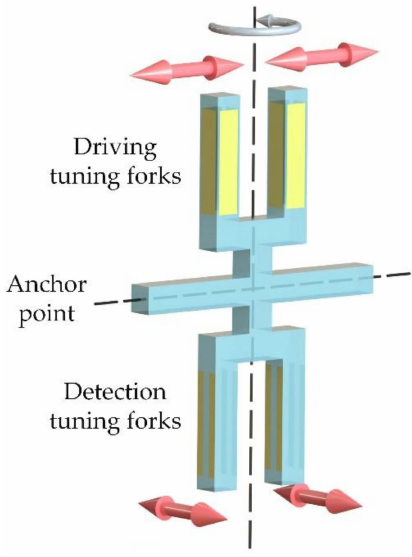
Figure 2. The principle of the tuning forks